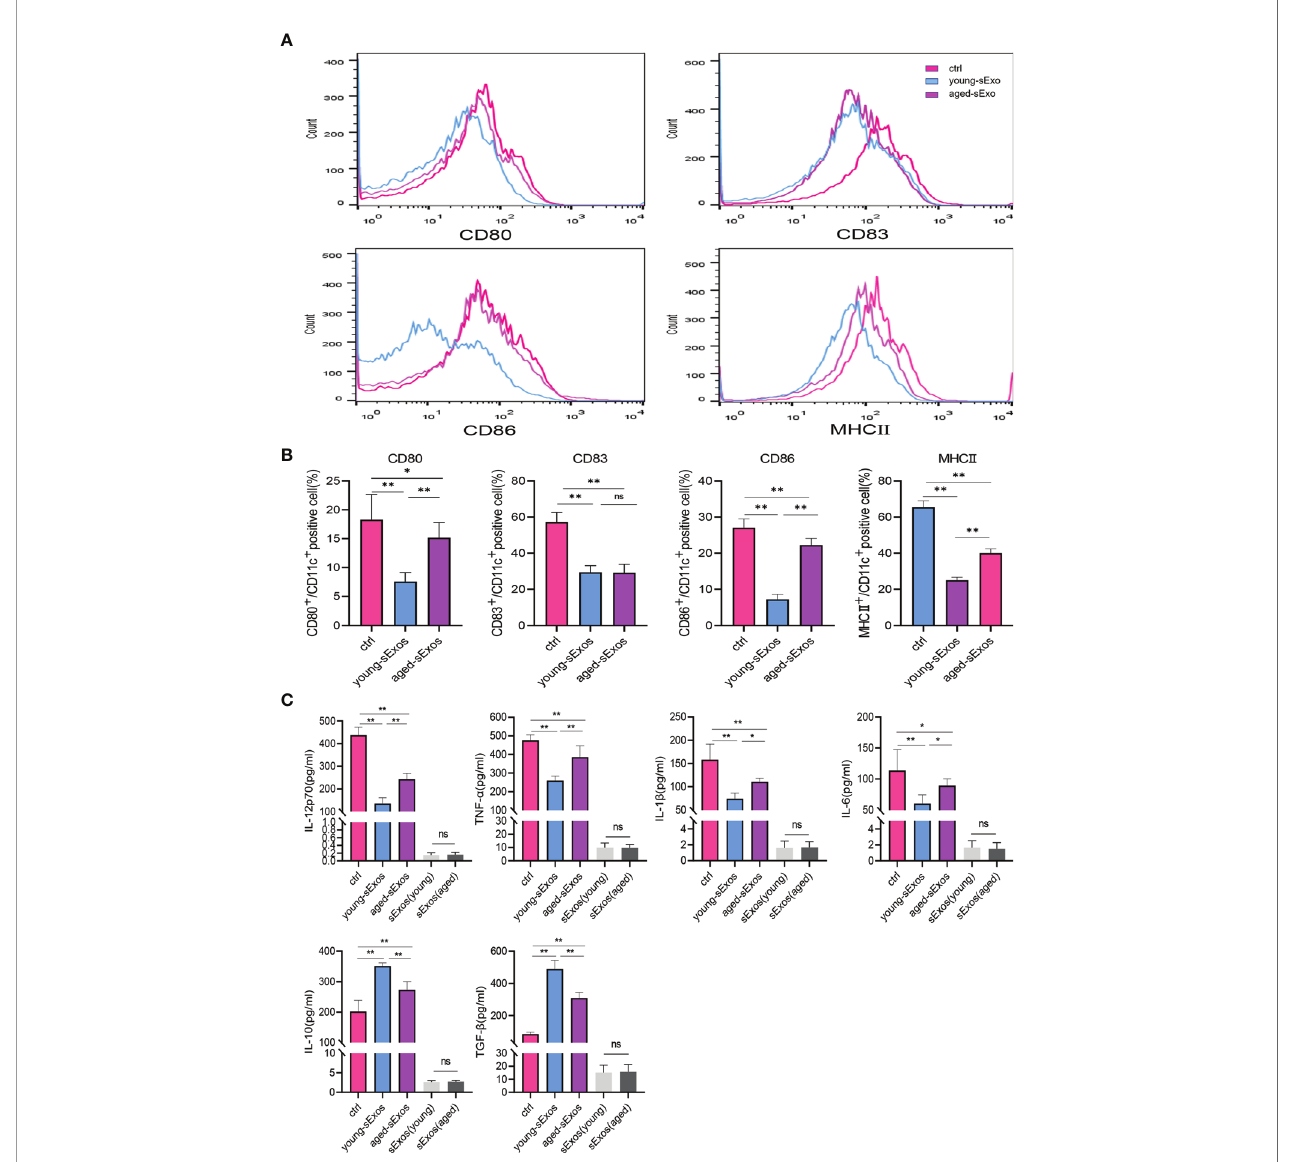
FIGURE 8 | Alterations of BMDC maturation status between young-sExos group and aged-sExos group in vitro . (A) Fluorescence-activated cell sorting (FACS) analysis of CD80, CD83, CD86, and MHCII in culture supernatant. The x-axis represents the fl uorescence intensity, and the y-axis represents the percentage of positive cells. (B) Quanti fi cation of CD11c+ CD80+ DC, CD11c+ CD83+ DC, CD11c+ CD86+ DC, CD11c+ MHCII+ DC positive cells as seen in panel A (mean ± SD, n = 6). (C) ELISA analysis demonstrating the concentration of IL-12p70, TNF- a , IL-1 b , IL-10, TGF- b , and IL-6 in the culture supernatant (mean ± SD, n = 6). The differences among different groups were assessed by one-way ANOVA with Holm – Sidak post-hoc test. *p < 0.05 and **p < 0.01. BMDC, marrow-derived dendritic cell; sExos, seminal plasma exosomes; ns, not signi fi